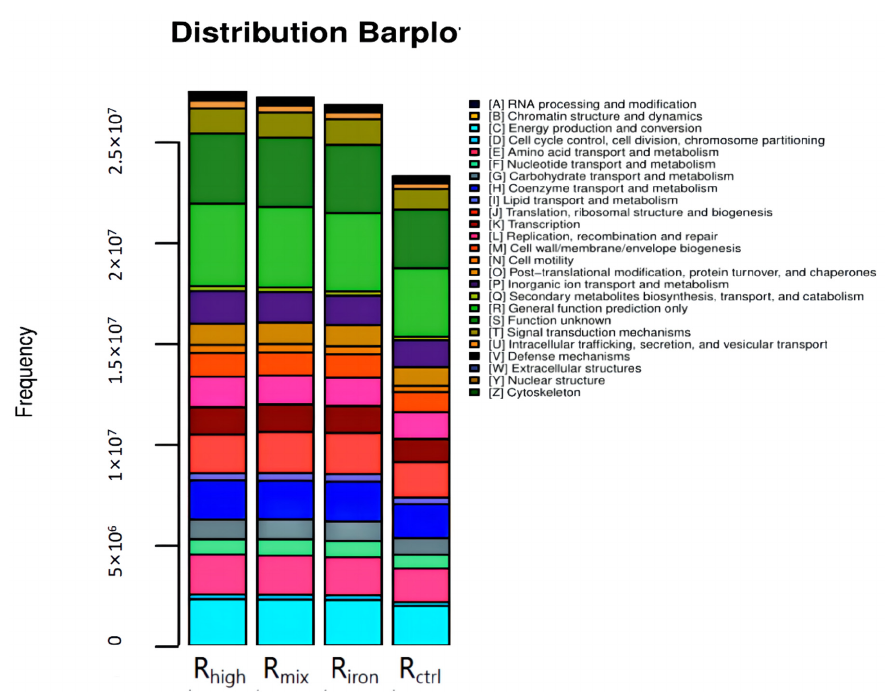
Figure 9. Functional abundance histogram of four reactors.